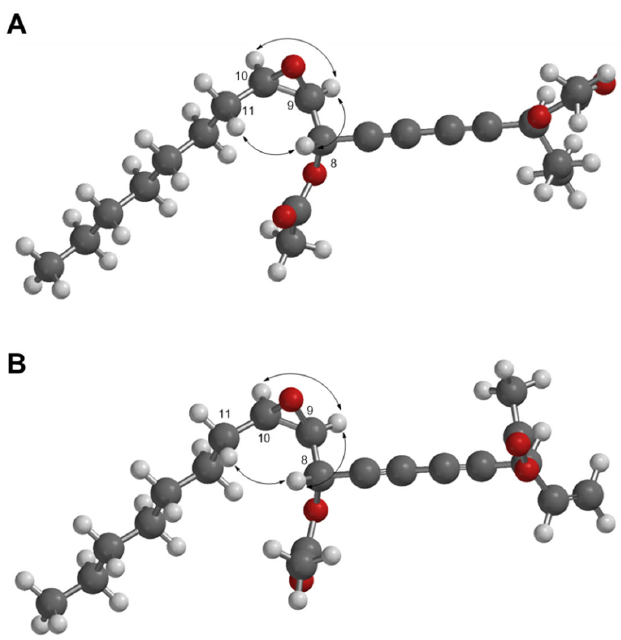
Figure 3. Key NOESY correlations ( ) between compounds 1 and 2 ( A , B ). The 3D structures of 1 and 2 were modeled by Spartan ′ 18.